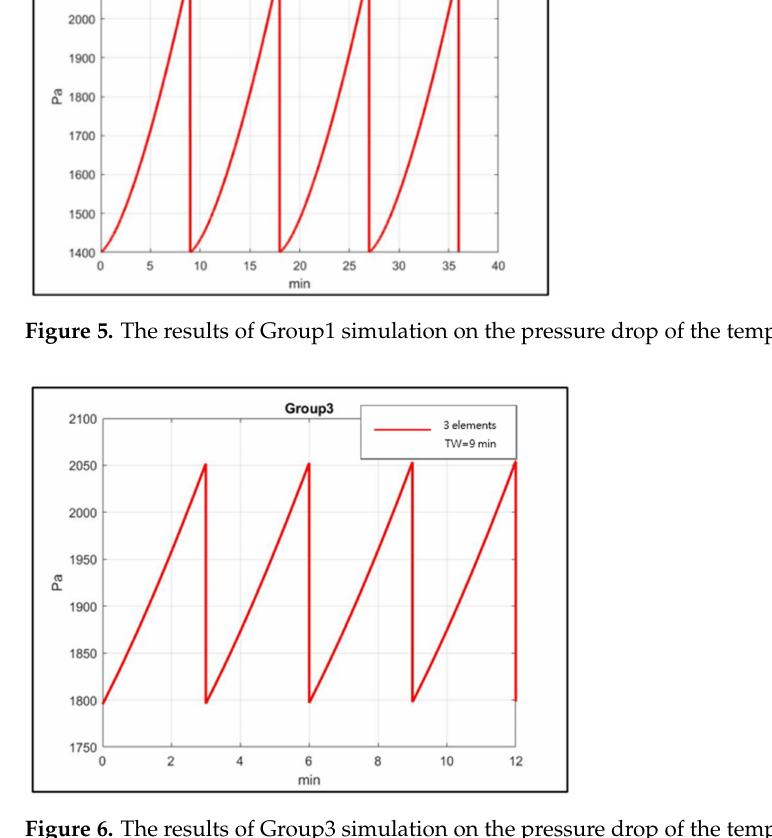
Figure 6. The results of Group3 simulation on the pressure drop of the temporary powder